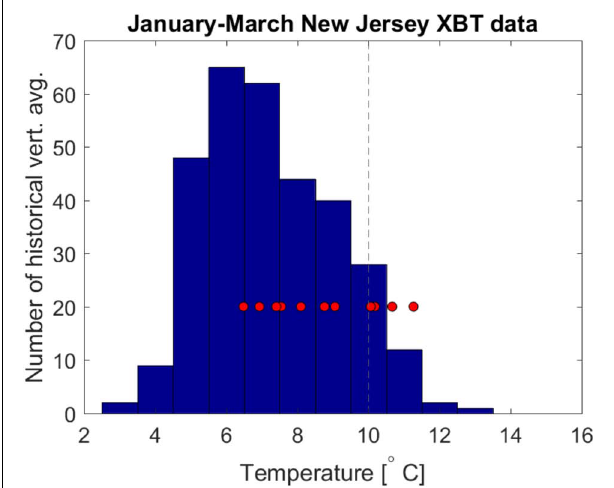
FIGURE 6 | Depth-averaged temperature from New Jersey from January 2017 relative to the distribution of historical depth averaged values from 1977 to 2017. Four of the eleven profiles qualify as a Marine Heatwave over the outer portion of the continental shelf. Two of the profiles have nearly identical temperatures. The area covered is between the 40 and 80 m isobaths, thus shoreward of the climatological position of the foot of the Shelfbreak Front. The dashed line indicates the 90th percentile for the historical temperature data.